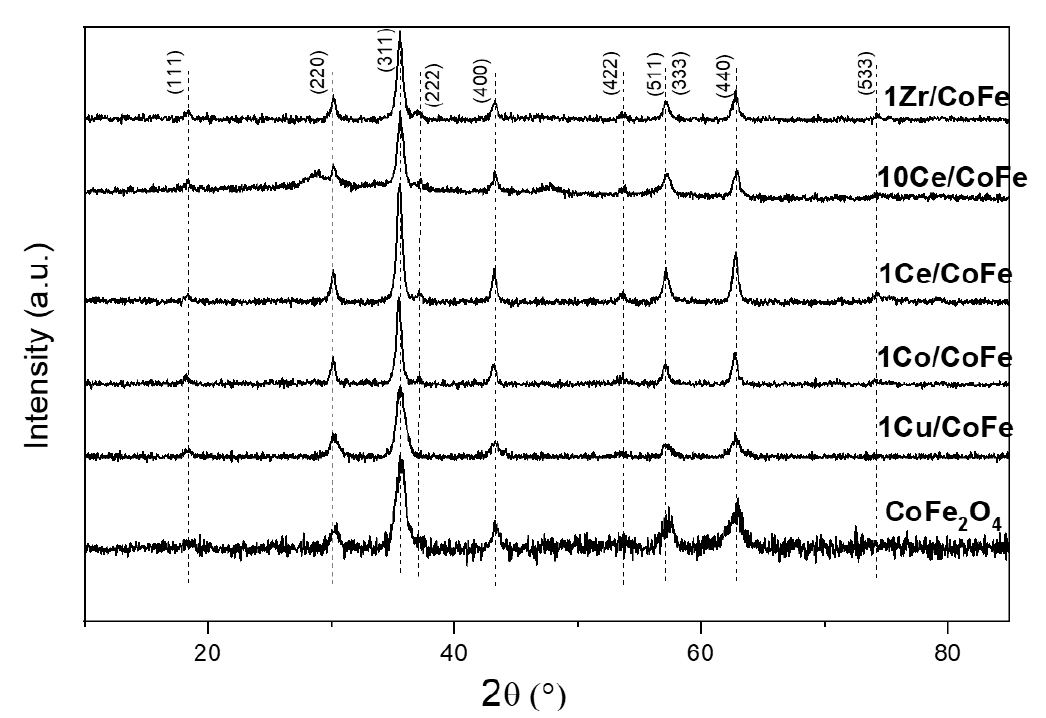
be present at the surface of 1Co/CoFe ( vide infra ), are expected to be reduced at tempera- tures in a similar range as those observed for CoFe 2 O 4 which, in addition to the broadness Figure 1. X-ray diffractograms of the indicated samples. Miller indexes for the CoFe 2 O 4 phase are marked. of the observed features, complicates the analysis of differences between both samples [25].